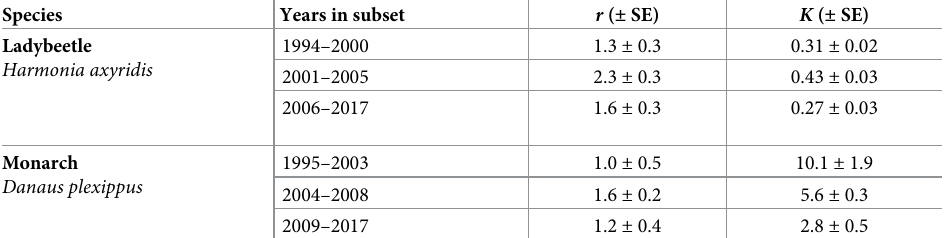
Table 1. Ricker model parameter values for each phase between break points resulting from fitting population data of 1) multicolored Asian ladybeetles from Michigan, USA (1994–2017), and 2) the area occupied by monarch butterflies in their winter habitat in central Mexico (1995–2017). The parameter r is the per capita yearly intrinsic rate of increase and K is the carrying capacity (e.g., average number of adult ladybeetles captured per trap annually and hectares occupied by monarchs